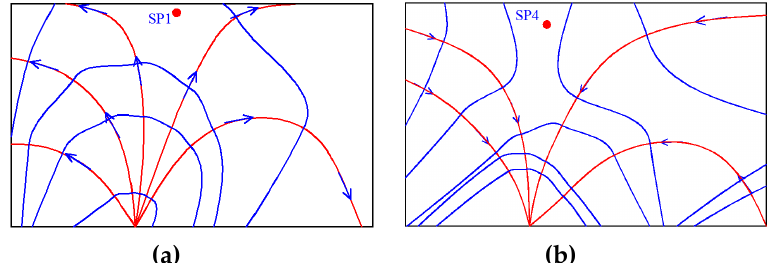
Figure 22. Distribution of hydraulic head (blue lines) and streamlines (red lines) around stagnation points SP1 ( a ) and SP4 ( b ).